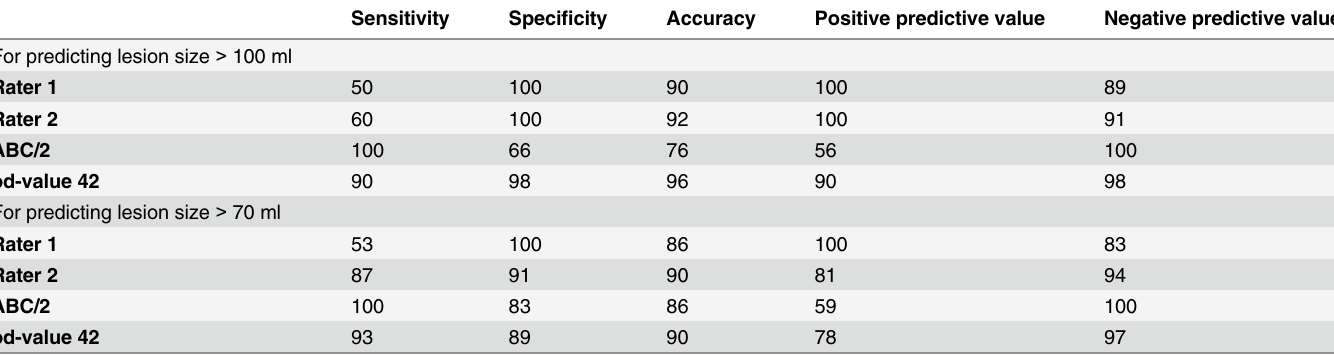
Data for rater 1 and 2 and the ABC/2 method were obtained from the compiled dataset of 50 patients. Od-values are obtained from the day 1 and day 2 lesions of the whole cohort (n = 108 for day 1 and n = 88 for day